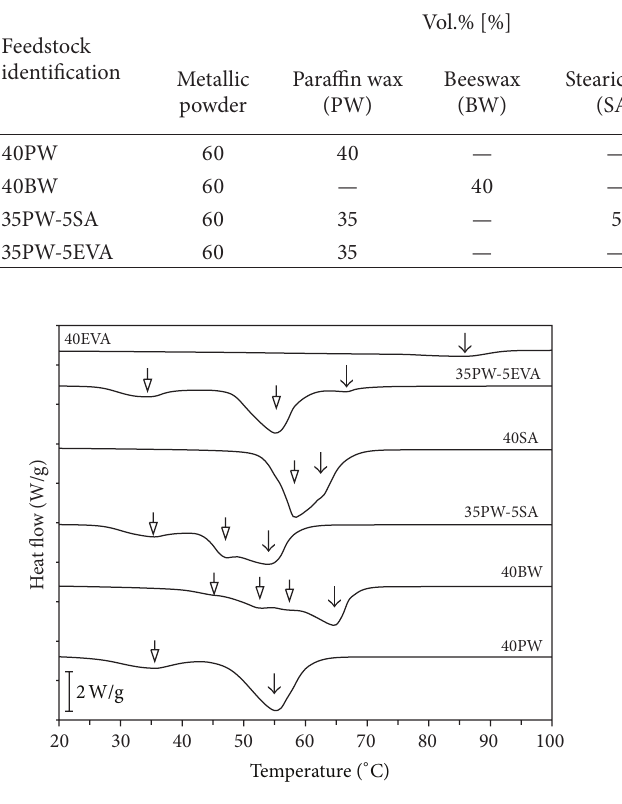
Figure 2: DSC thermogram of binders. Figure 3: TGA profiles of feedstocks.